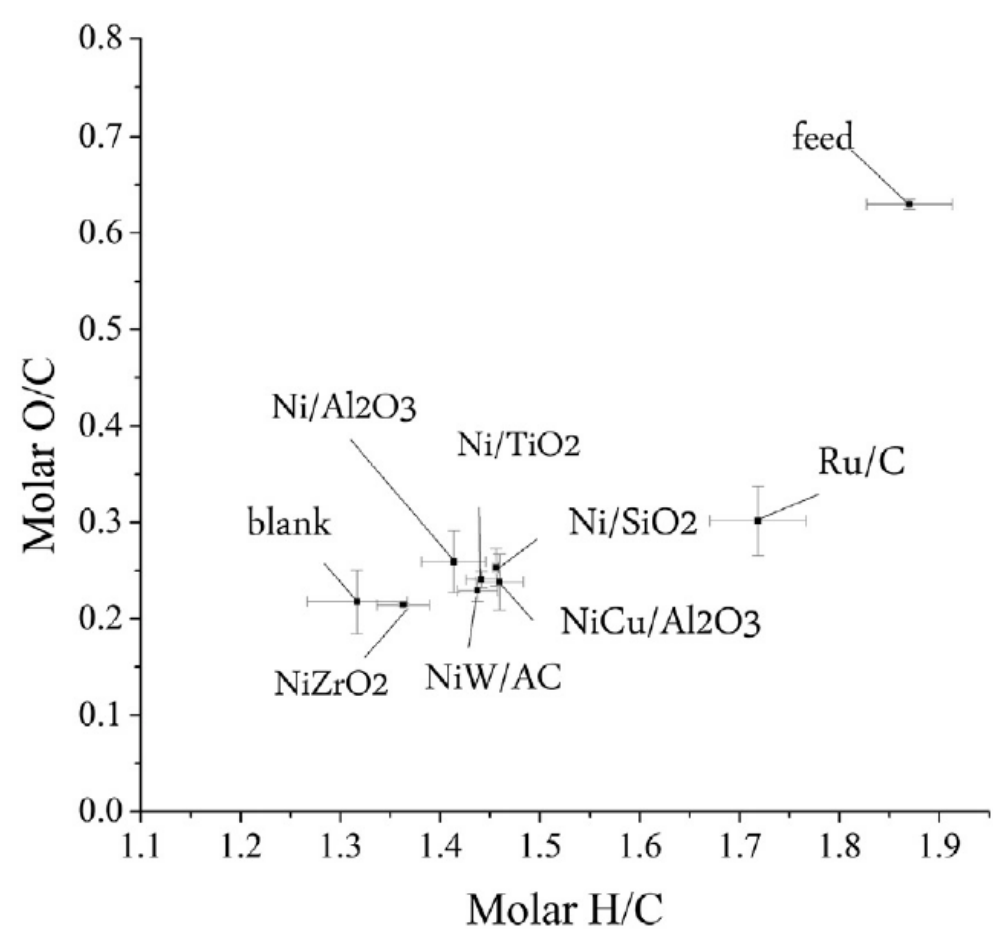
Figure 1. Van Krevelan plot of the light phase of pyrolysis oil prepared from wheat straw and its upgraded products using different catalysts at 250 °C under 80 bar hydrogen [35].